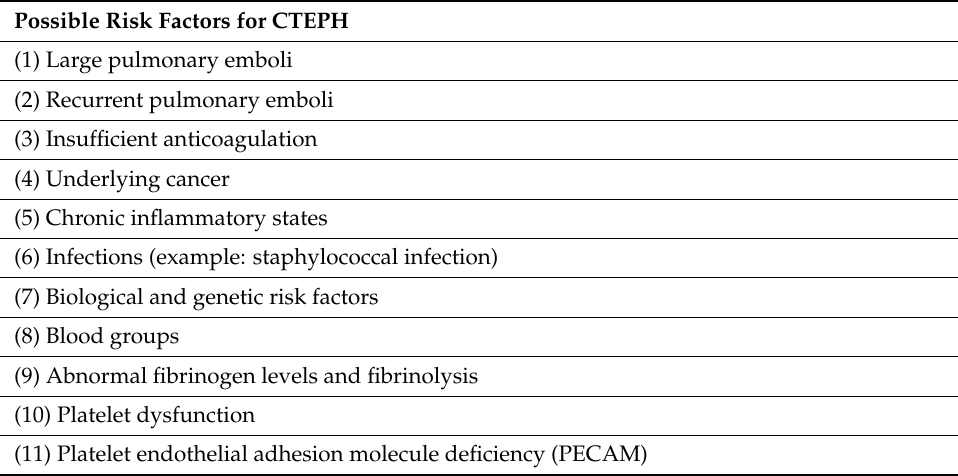
Table 3. Some of the possible risk factors for the development of